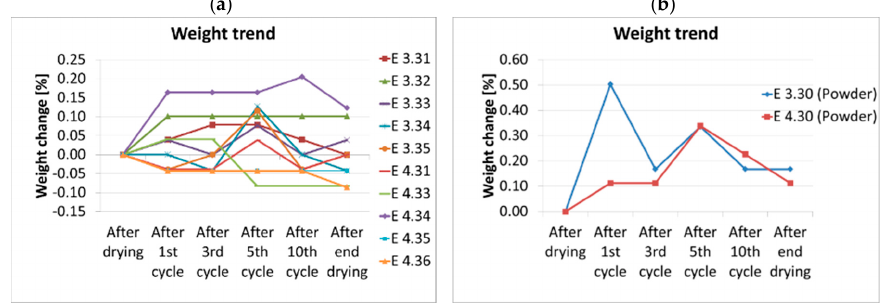
Figure 16. Weight of sintered slag pebbles ( a ) and powder made of sintered slag pebbles ( b ) over the duration of thermal cycling.